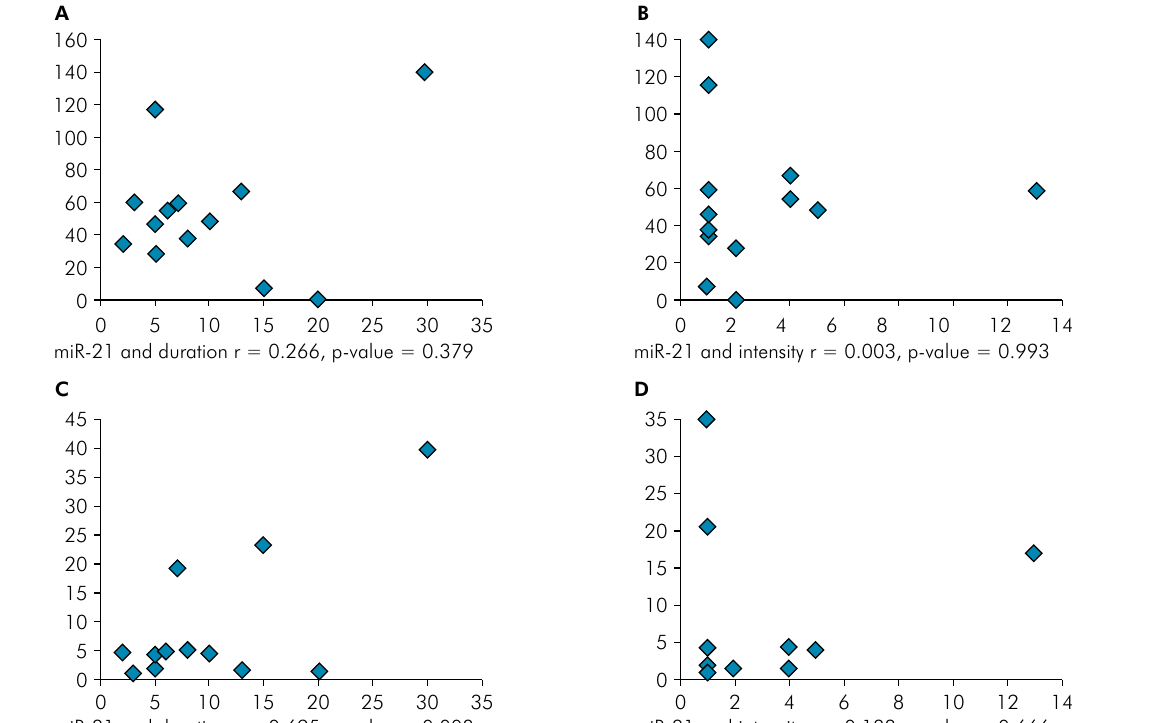
Figure 4. Correlation between tobacco chewing intensity and duration with fold difference of miRNA-21 and